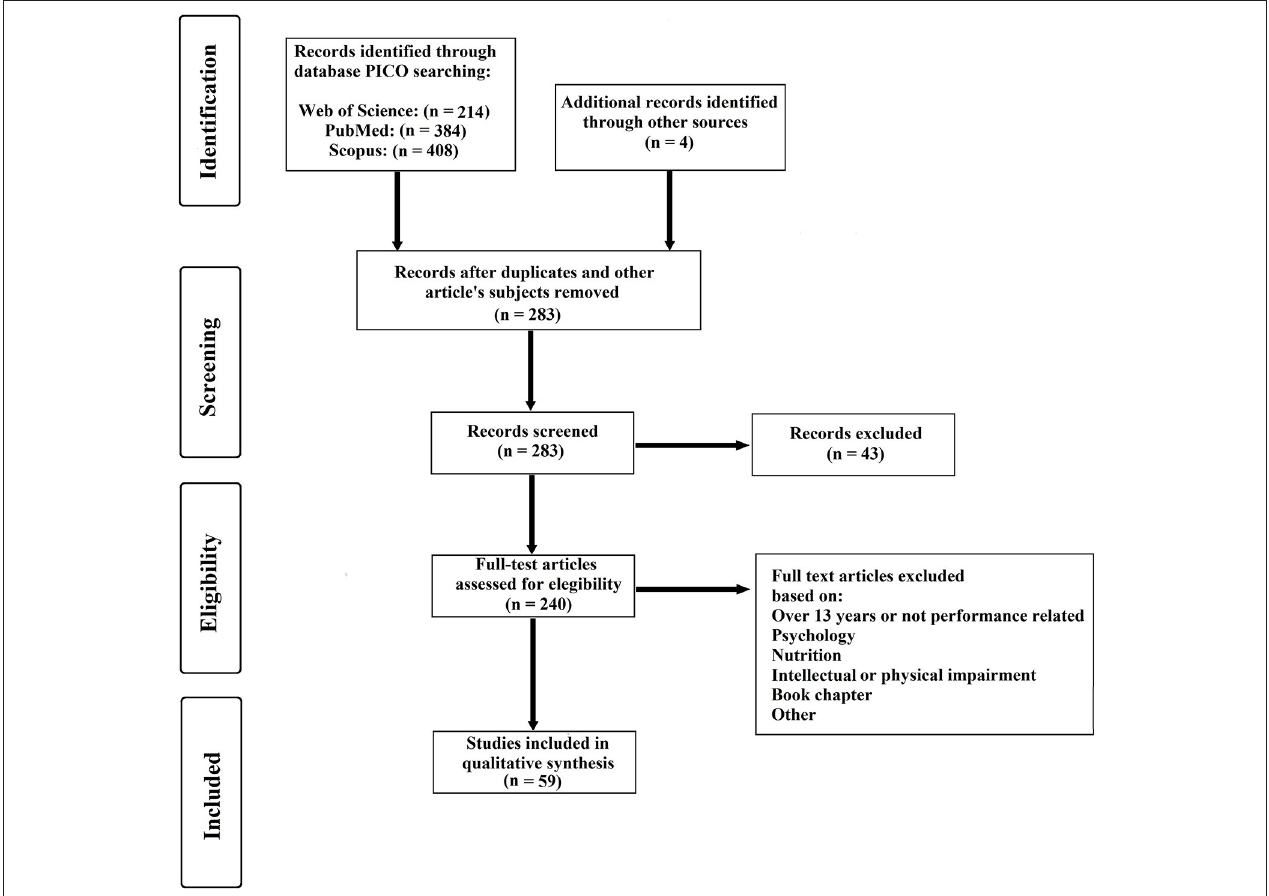
FIGURE 1 | Summary of PRISMA flow for search